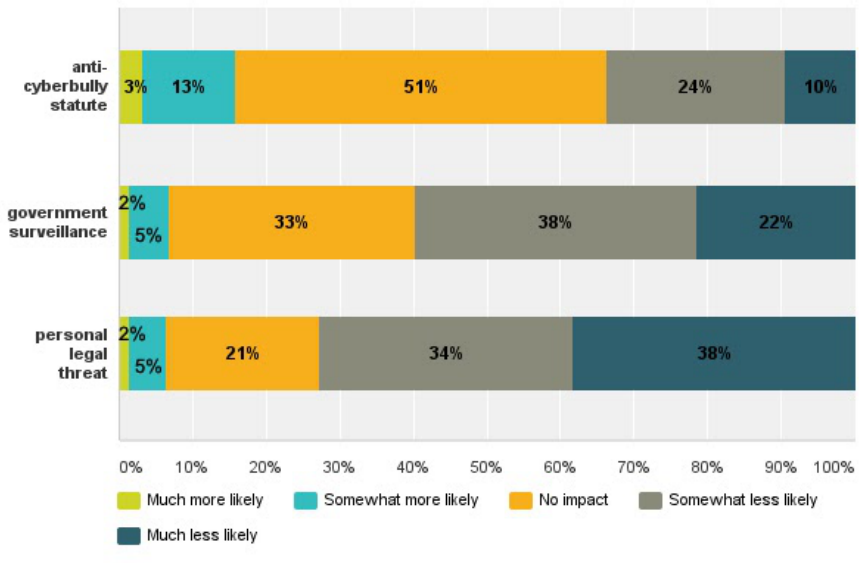
Figure 4: Impact on online sharing (personally created content) Respondents were asked whether they would be “more likely or less likely to share content on the internet that [the respondent] personally created, authored, or made (e.g., a digital photo, song, blog post, Facebook status update, etc)” in response to each hypothetical scenario. This chart maps the responses consistent with previous